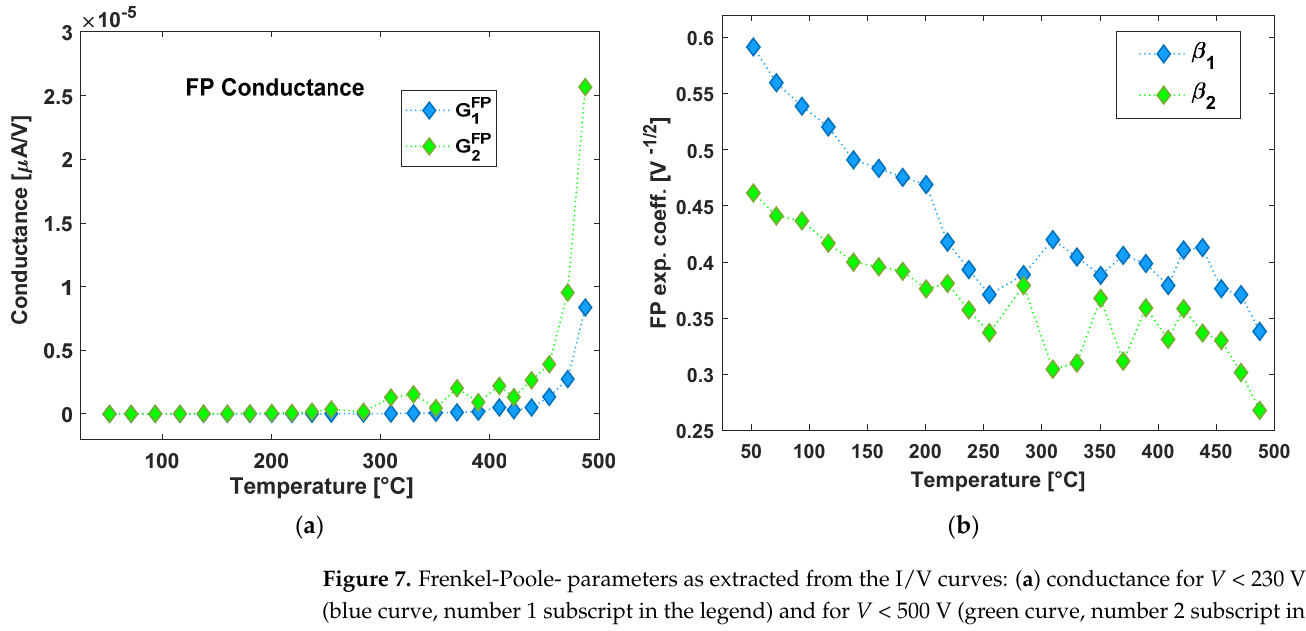
Figure 7. Frenkel-Poole- parameters as extracted from the I/V curves: ( a ) conductance for V < 230 V (blue curve, number 1 subscript in the legend) and for V < 500 V (green curve, number 2 subscript in the legend); ( b ) Extraction of the exponential coefficient for V < 230 V (blue curve, number 1 subscript in the legend) and for V < 500 V (green curve, number 2 subscript in the legend).